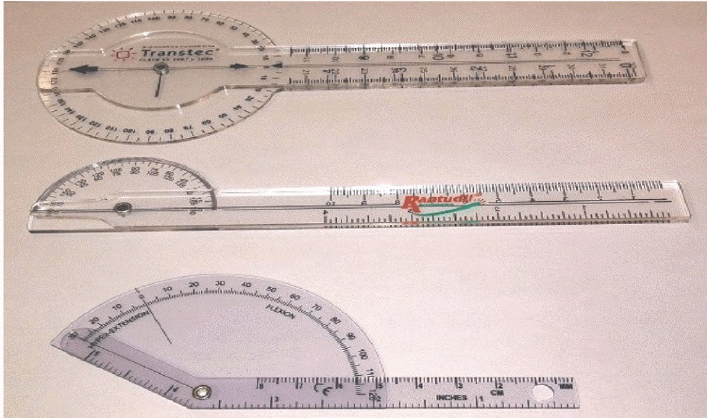
Figure 9. Knee Extension with Extension Plantarflexion.